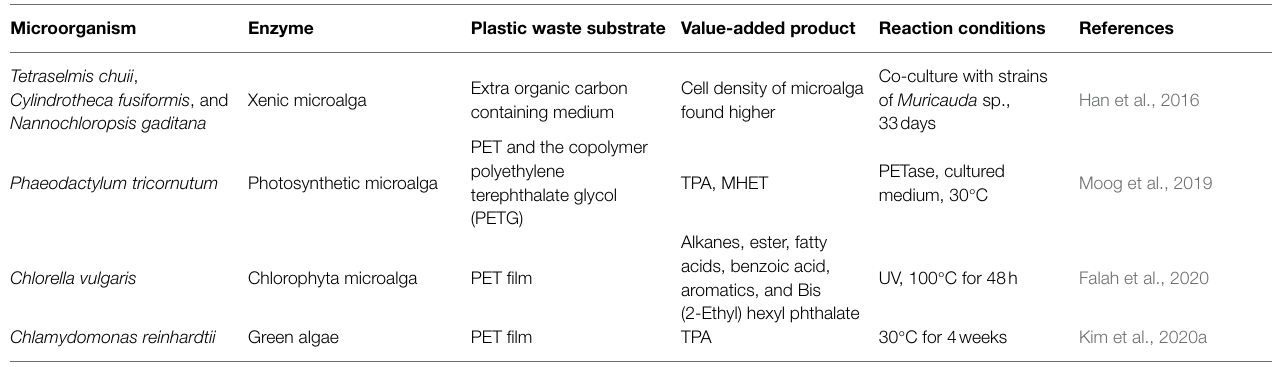
TABLE 4 | Plastic biodegradation using different enzymes derived from